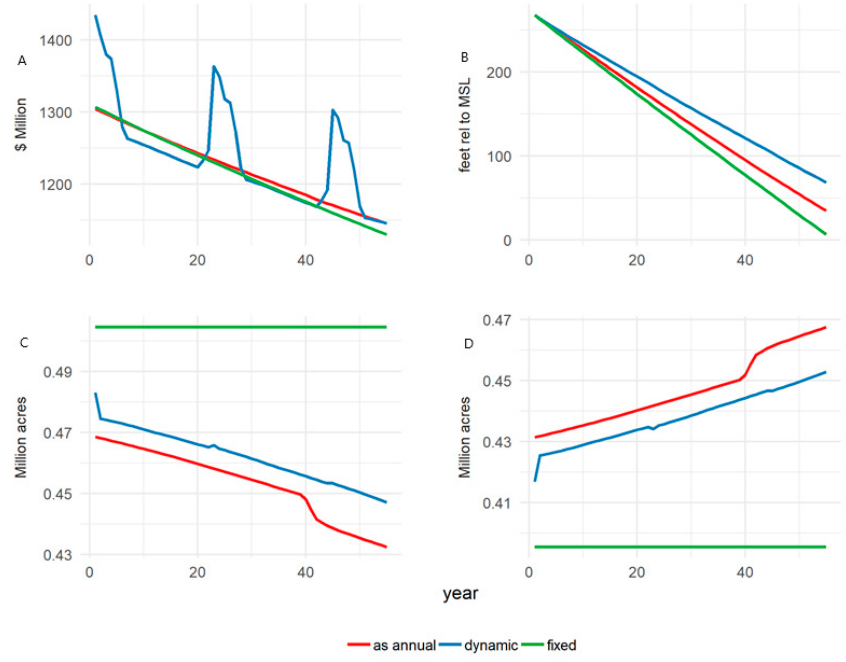
Figure 5. Model comparison under baseline scenario, key time series. ( A ) annual net benefits, ( B ) aquifer height, ( C ) perennial area, and ( D ) annual area.